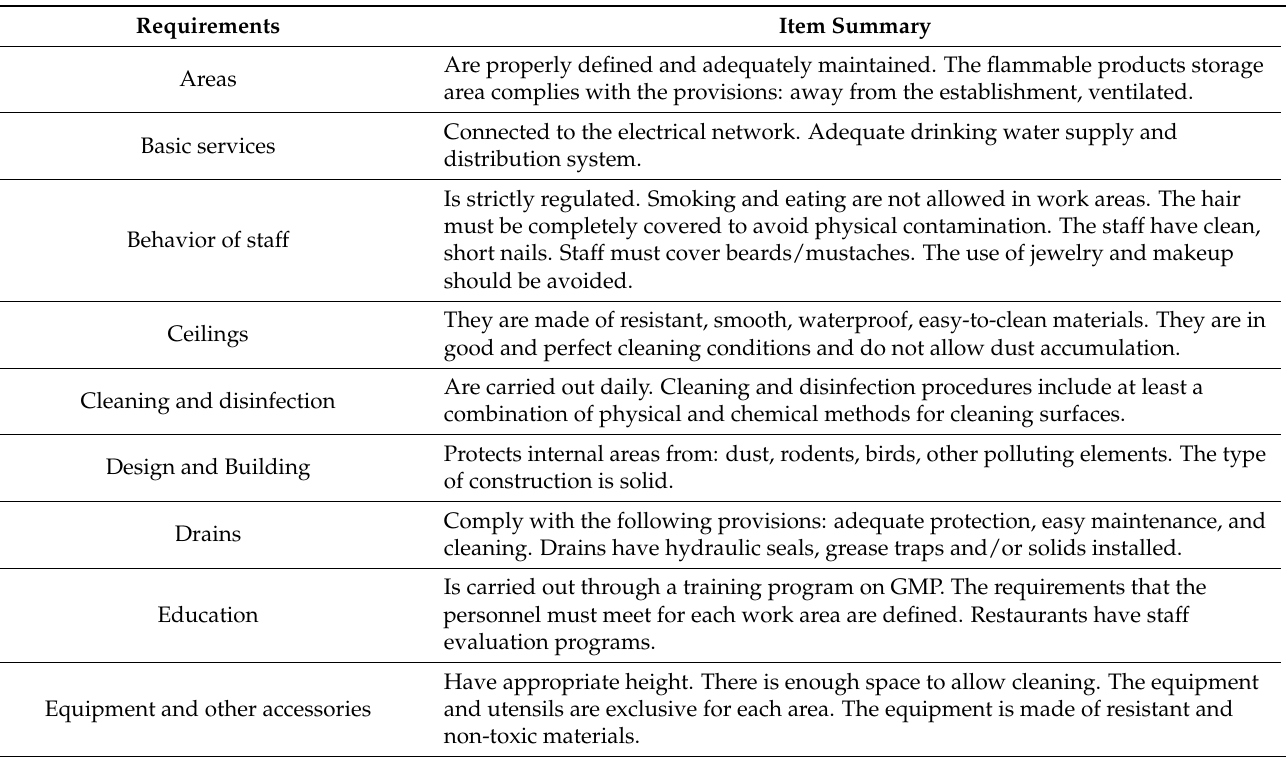
Table 2. Requirements of the Ecuadorian law that regulate GMP in